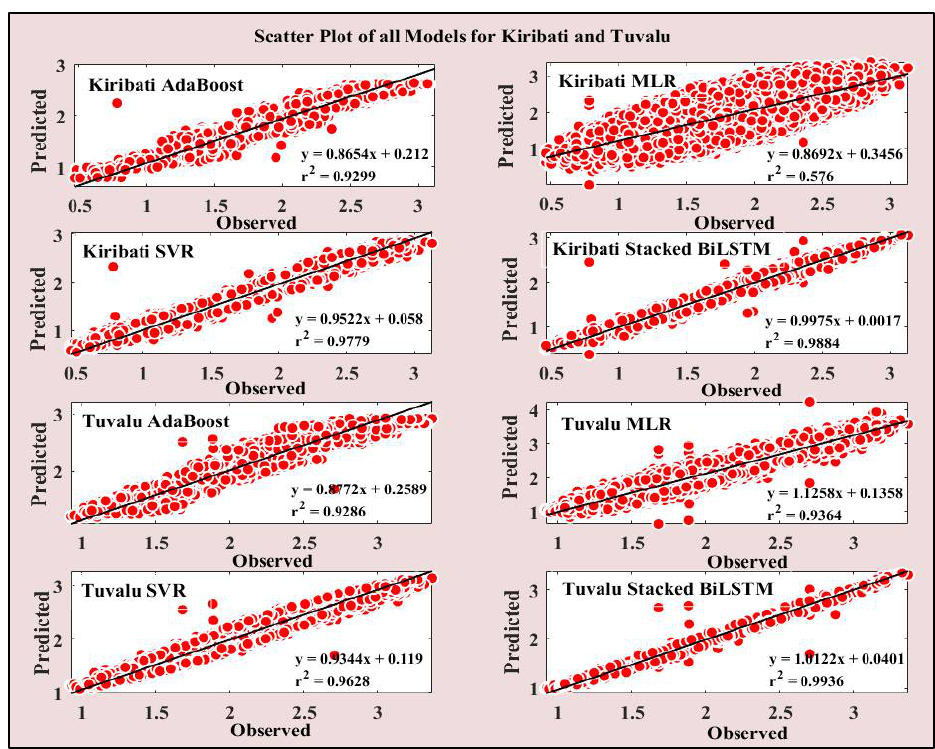
Figure 11. Scatterplot subplots of Kiribati and Tuvalu for all models showing the line of best fit and r 2 values between observed and predicted values.